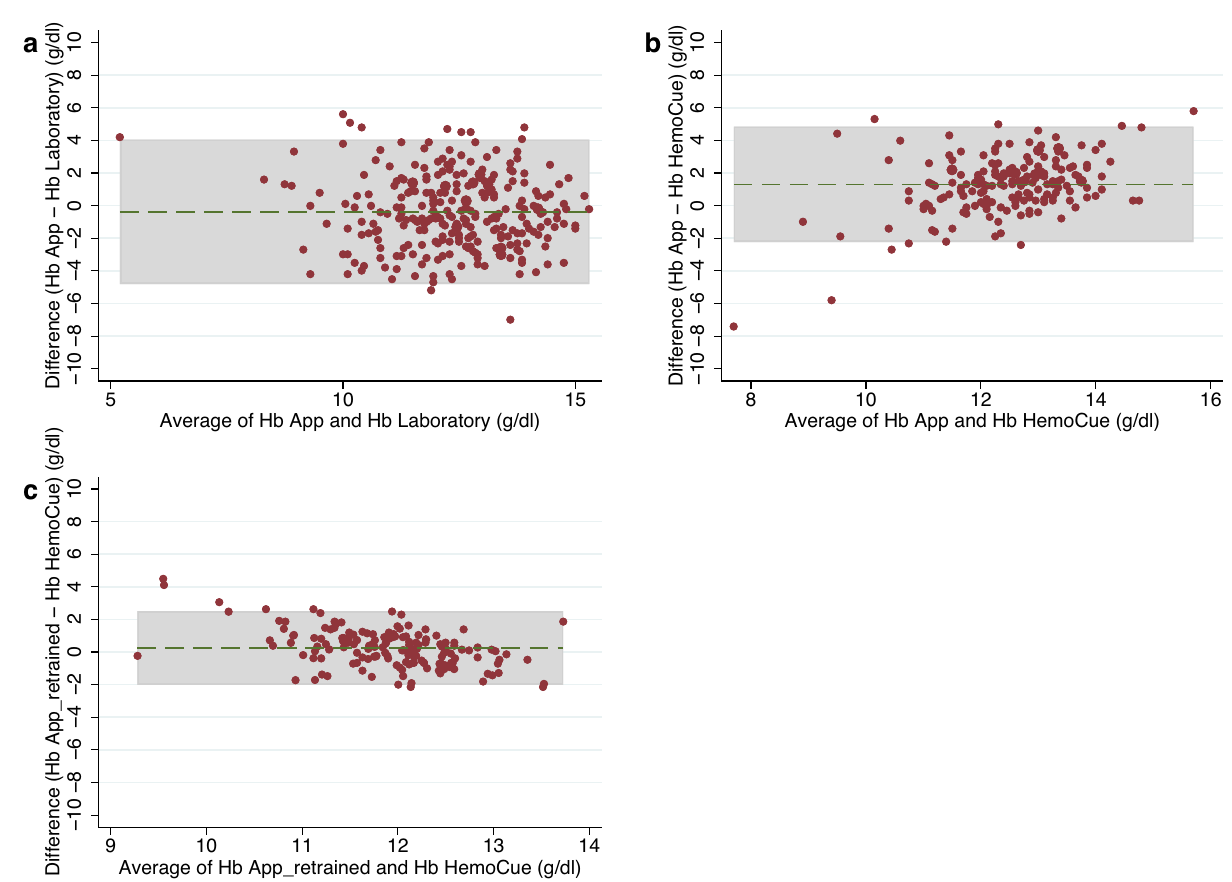
Fig. 3 Bland-Altman plot. Bland-Altman plot. The green dashed line represents the mean difference (bias), the gray shaded area represents the 95% limits of agreement (LoA), determined as bias ±1.96 SD; a for clinic-based sample, difference (Hb App – Hb Laboratory) on y-axis, average of Hb App and Hb Laboratory on x-axis, bias = − 0.38 g/dl, LoA = − 4.81, 4.05 ( n = 272); b for pre-school sample, difference (Hb App – Hb HemoCue) on y-axis, average of Hb App and Hb HemoCue on x-axis, bias = 1.30 g/dl, LoA = − 2.23, 4.84 ( n = 179); c for retrained App, difference (Hb App_retrained – Hb HemoCue) on y-axis, average of Hb App_retrained and Hb HemoCue on x-axis, bias = 0.25 g/dl, LoA = − 2.01, 2.50 ( n = 160). Source data for a is in Supplementary Data 1; source data for b and c is in Supplementary Data 2. Table 3 Validity of Smartphone App. Comparison of methods n